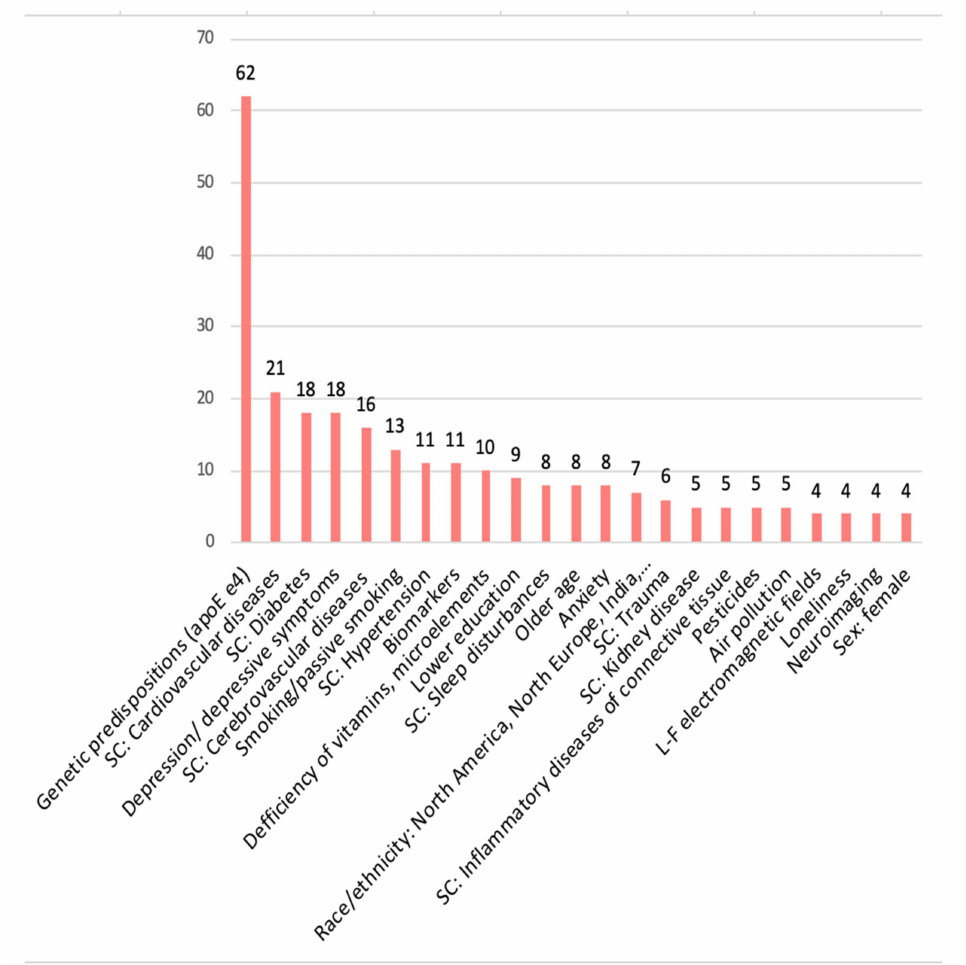
Figure 5. The most frequently studied risk factors.